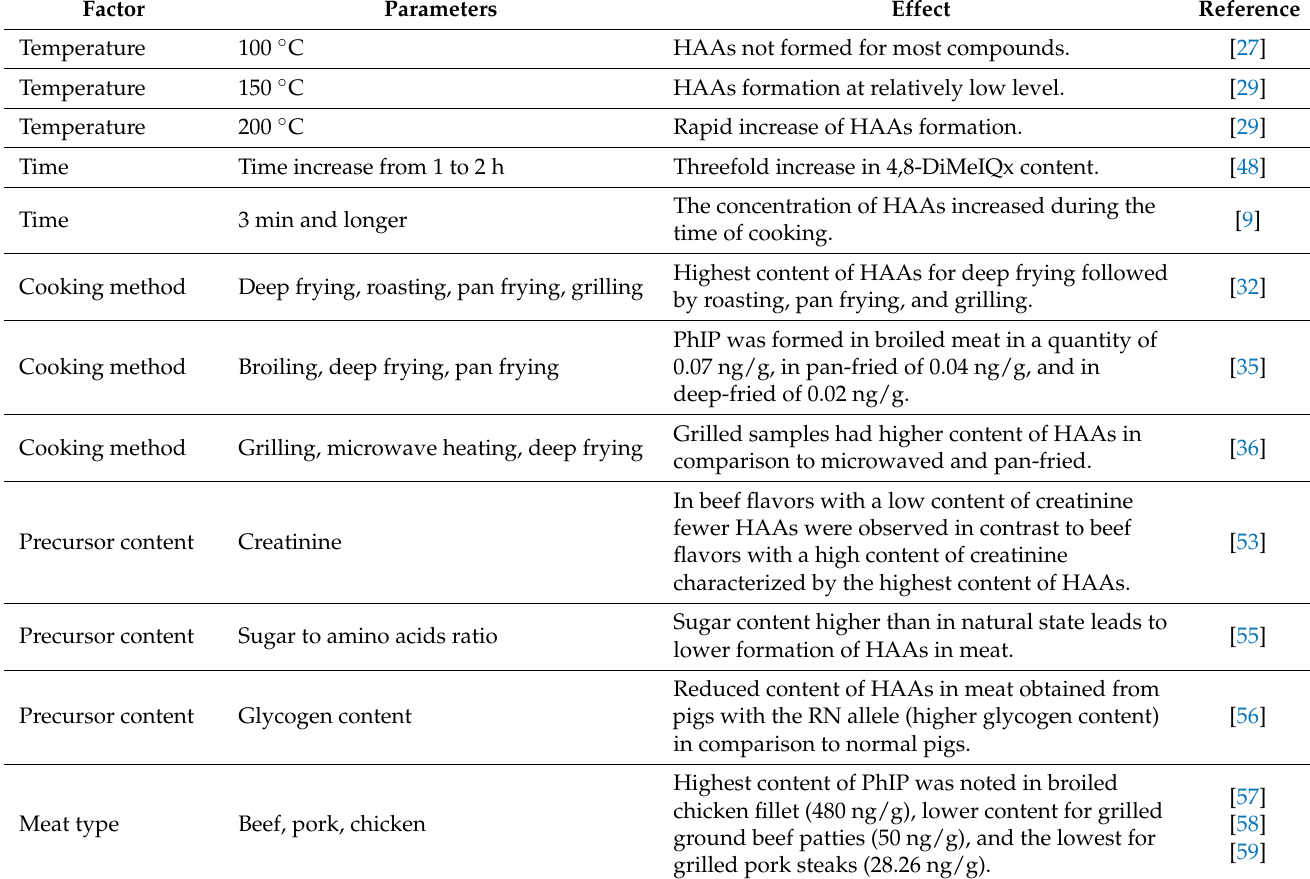
Table 2. Factors affecting heterocyclic aromatic amines content and/or mutagenic activity of meat samples or designed laboratory